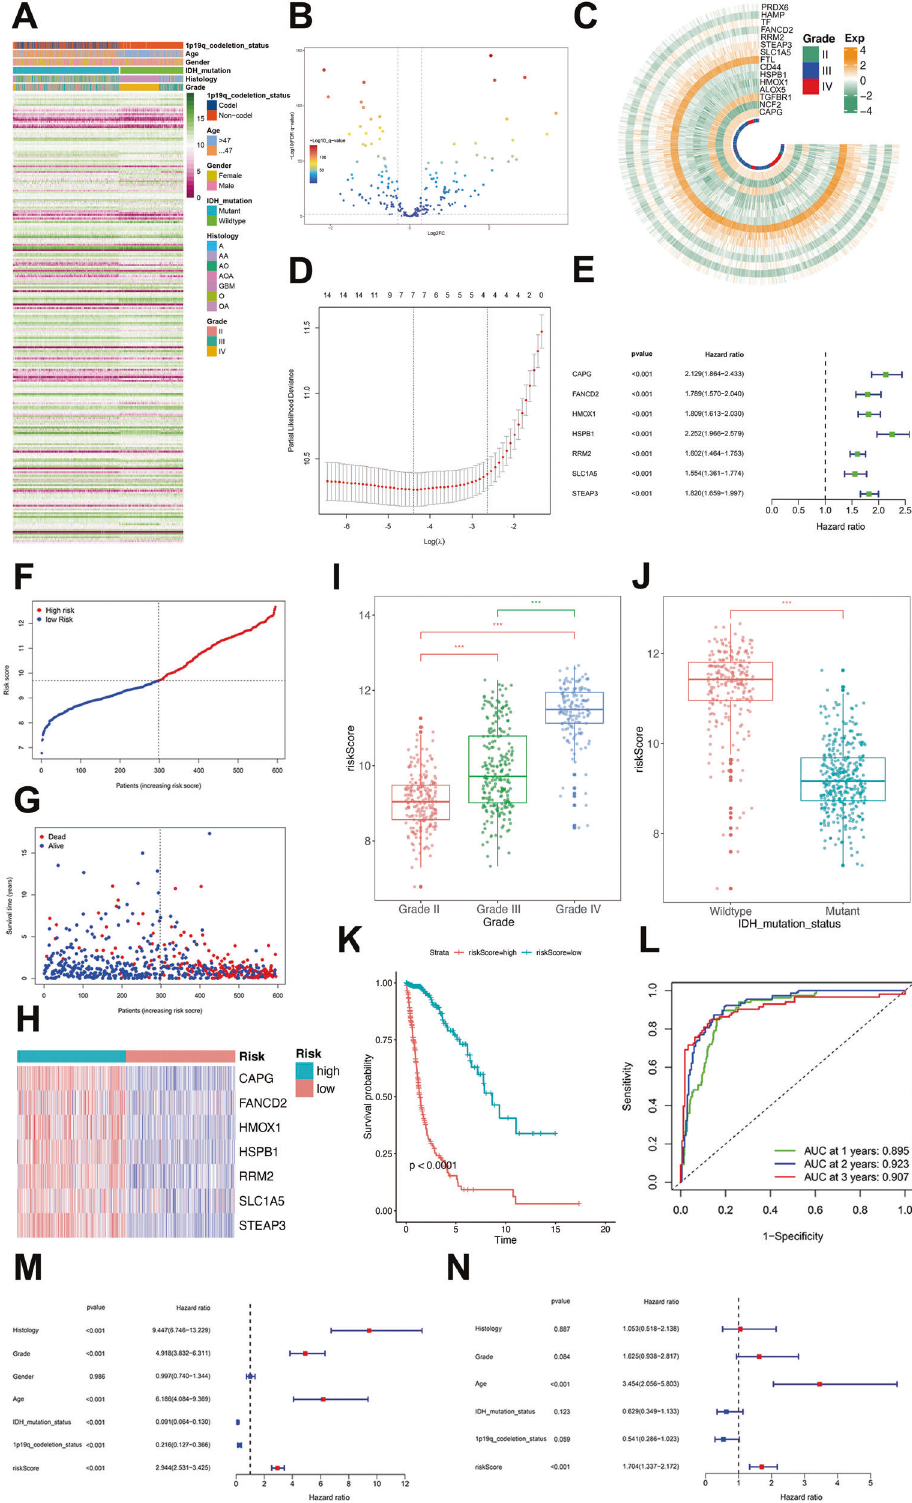
Fig. 1 Establishment of an FRGs-related prognostic model in the TCGA cohort. A The expression of the total 242 FRGs identi fi ed from FerrDb in the TCGA cohort. B The differentially expressed FRGs between GBM and low-grade glioma patients. C The expression of 15 independent prognosis ferroptosis-related DEGs in TCGA cohort. D The prognostic model was constructed by 15 FRGs through LASSO regression analysis. E Univariate-Cox regression analysis of each gene in the model. F Patients were divided into high-risk and low-risk groups. G The relationship between survival state and risk score. H The expression of seven FRGs of the model in the high-risk group and low-risk groups. I The relationship between the risk score and WHO grade. J The relationship between the risk score and IDH mutation status. K Kaplan – Meier survival analysis for the survival time of high-risk patients and low-risk patients. L The ROC curves and AUC of the risk score in TCGA datasbase. Univariate-( M ) and multivariate-( N ) Cox regression analysis of the risk score. Cell Death and Disease (2022)